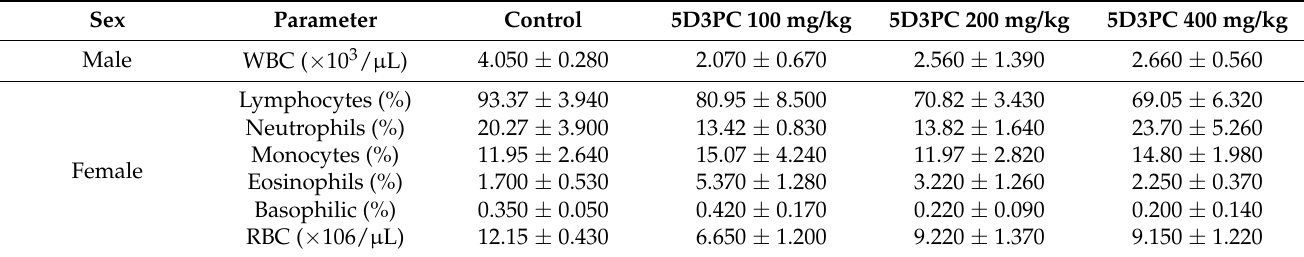
Table 2. Effect of 5D3PC (2000 mg/kg) on hematological and biochemical profilin ICR mice from 14 days acute toxicity